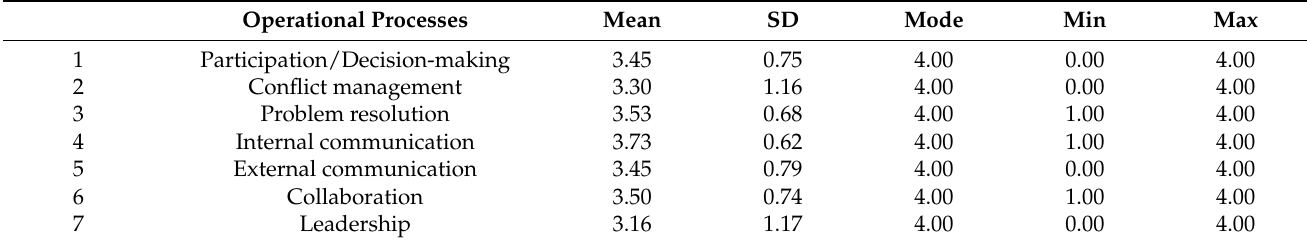
Table 9. Descriptive statistics of the working groups in operational